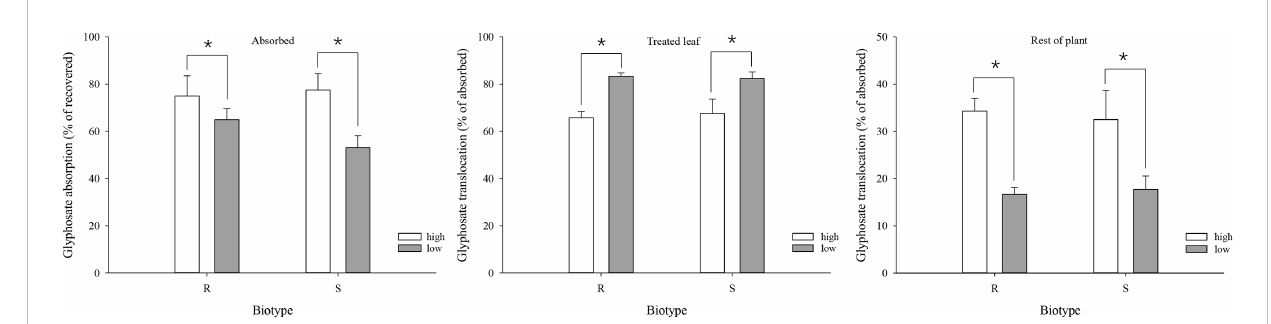
FIGURE 4 Glyphosate absorption and translocation in glyphosate-resistant (R) and -susceptible (S) Eleusine indica biotypes at 3 days after glypphosate treatment under high temperature (30°C/25°C day/night) and low temperature (20°C/15°C day/night) regimes. Each data point is the mean ± standard error of three biological replications. An asterisk indicates a signi fi cant difference between temperature regimes (Student ’ s t -test, a =